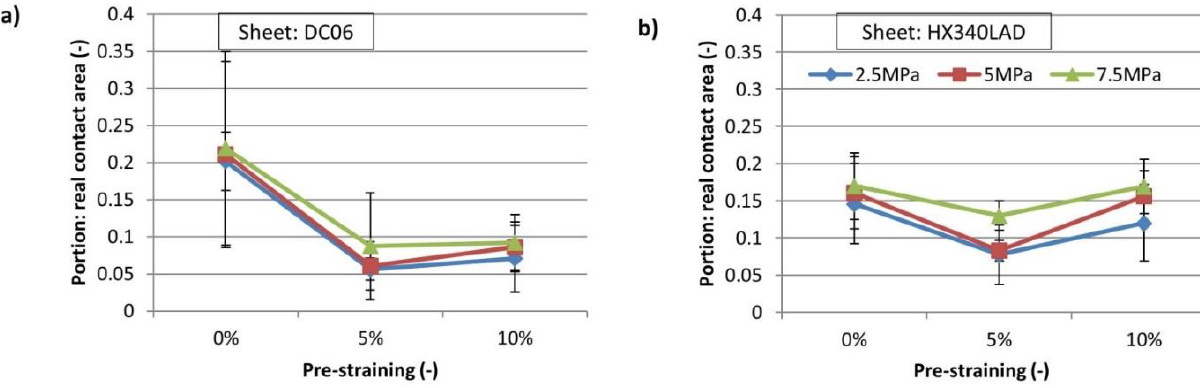
Figure 20. Draw bead geometry for strip drawing tests (BH = blank holder; DB = Draw bead).